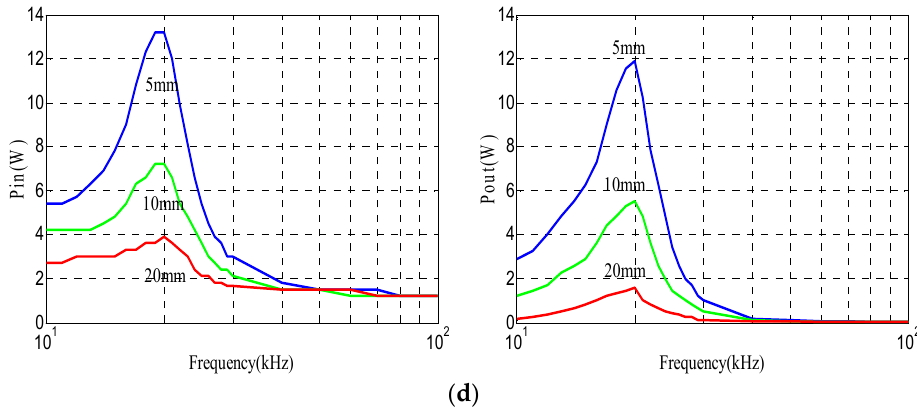
Figure 3. Frequency response of the IPT system based on EE-shaped cores with varied air gap. ( a ) SP topology (MATLAB); ( b ) P topology (MATLAB); ( c ) Input power and output power of SP topology